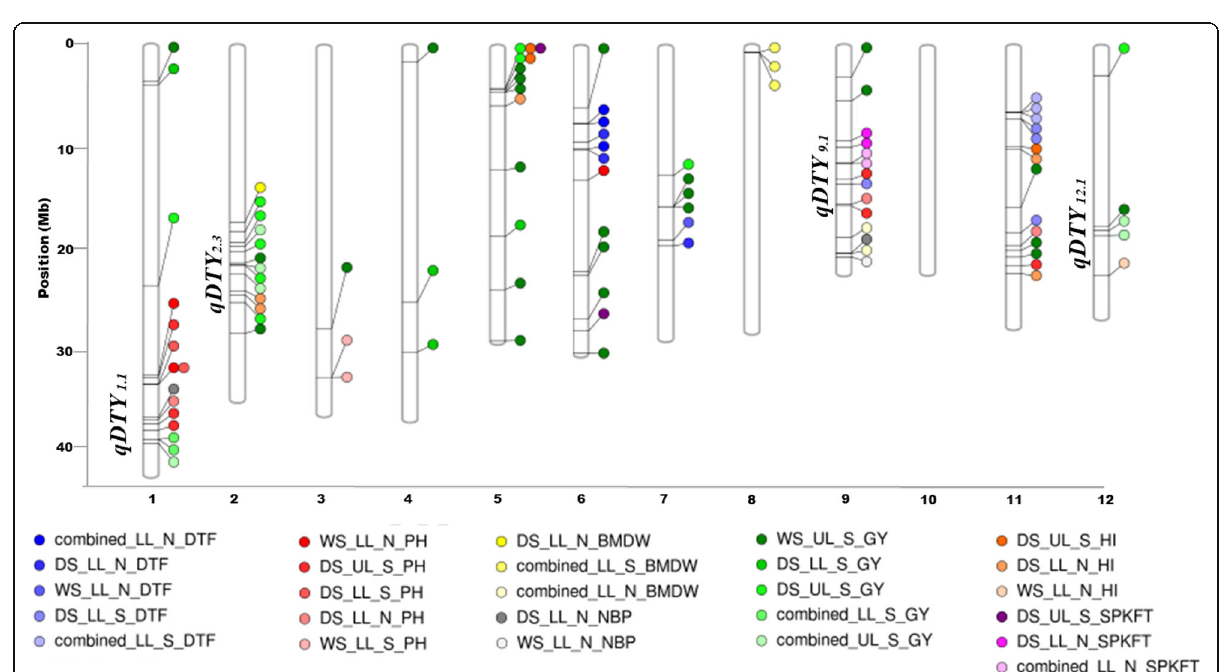
Fig. 8 Genomic locations of 101 significant MTAs detected within a 200 kb window in reported genes and drought QTLs ( qDTYs) . Colored circles show the position of each MTA for 7 traits: Days to 50% flowering-DTF, Plant height-PH, Biomass-BMDW, Number of effective panicles-NBP, Grain yield-GY, Harvest index-HI and Spikelet fertility-SPKFT from each of the six experiments (lowland non stress-LL_N, lowland stress-LL_S and upland stress-UL_S) in the two seasons (WS and DS) and combined season analysis. Exact genomic locations are shown in Table